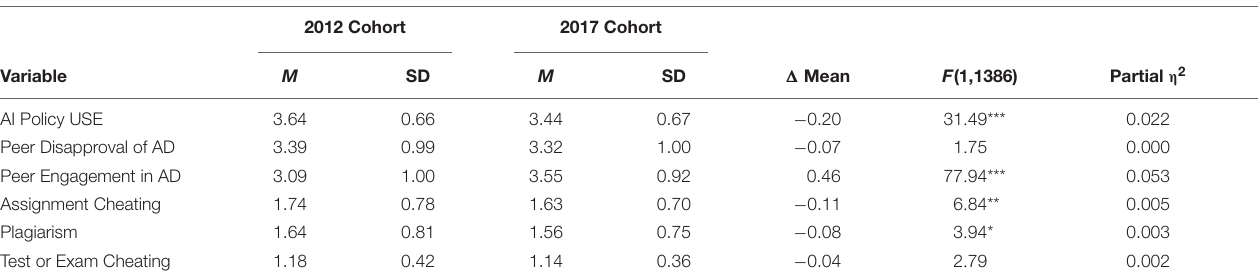
TABLE 6 | Tests of hypotheses: results from ANOVA comparing cohorts.